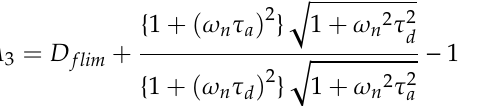
Figure 4. Vector diagram of UMZV DRF shaper.